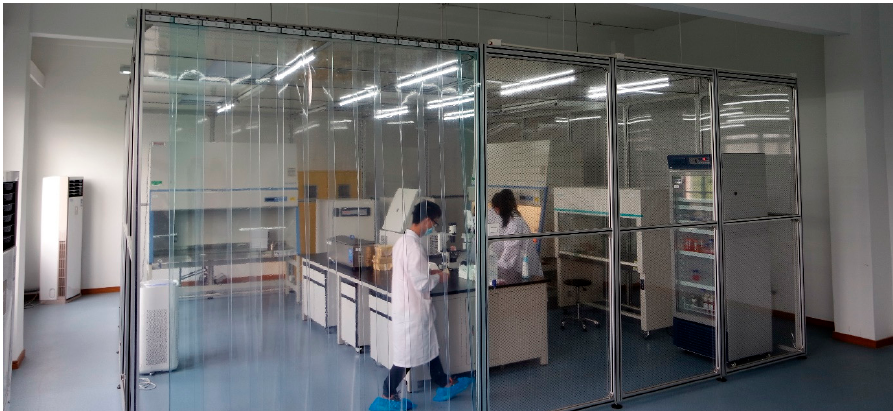
Figure 4. The Shanghai University (SHU) iSmart Institute cell culture room for the organ-on-chip (OoC) experiments. The area is isolated, with the high efficiency particulate air (HEPA) filtration, temperature and humidity control. The air pressure inside is kept positive to keep away the outside air. The cell culture room has an area of 30 m 2 (5 × 6 m) and accommodates the instruments necessary for work: refrigerators, freezers, cell culture incubators, biological safety cabinet, microscope, and chip setup with fluid control.